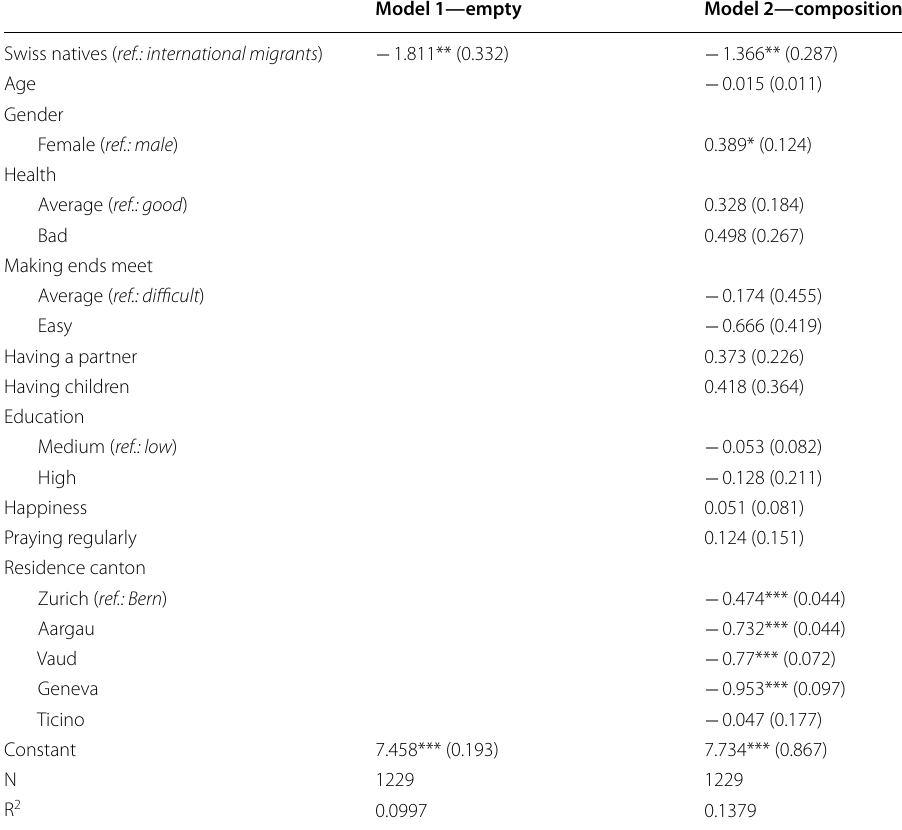
Table 3 Linear regressions to test composition effects on worry about the